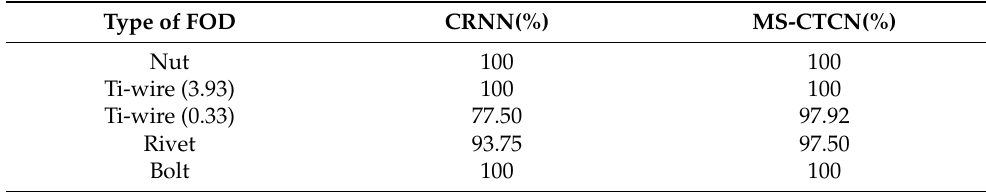
Table 4. The accuracy of CRNN and MS-CTCN for different